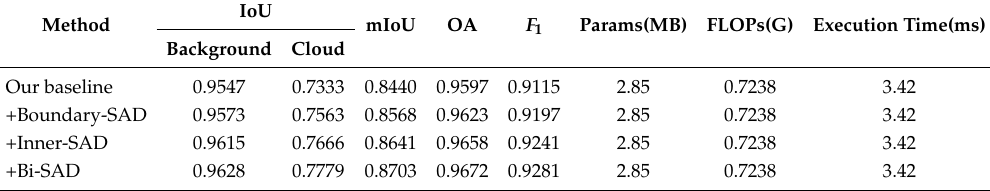
Table 1. The results of training baseline model with our proposed distillation methods. + Boundary-SAD denotes training the baseline model with Boundary-SAD. + Inner-SAD denotes training the baseline model with Inner-SAD. + Bi-SAD denotes training the baseline model with Boundary-SAD and Inner-SAD.